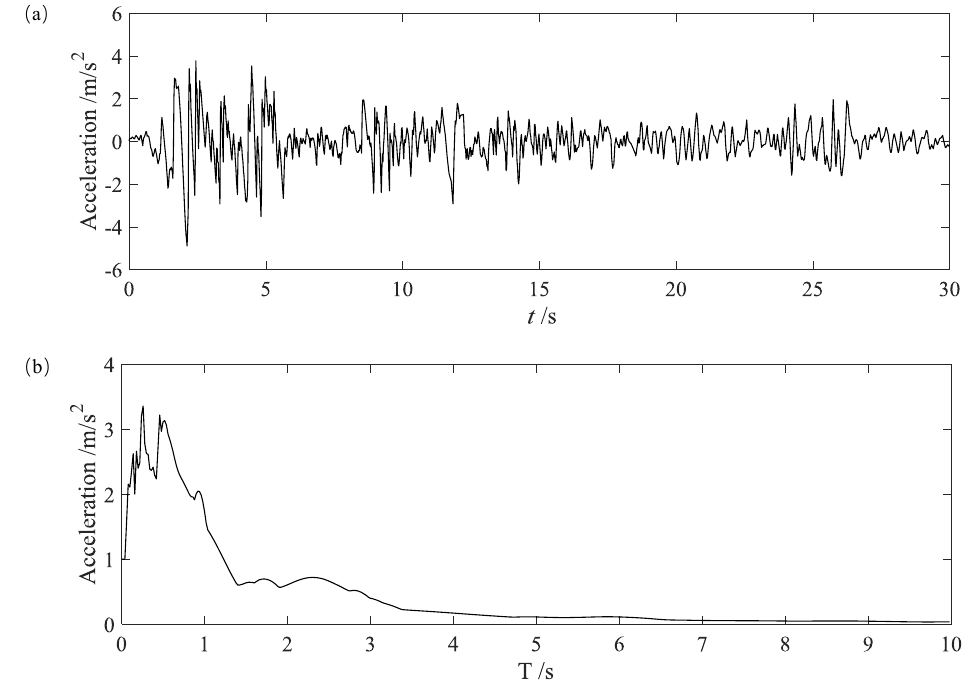
Figure 12. Spectral characteristics of the El Centro wave. ( a ) Time history. ( b ) Response spectrum. Numerical results for the initial conditions of u ( 0 ) = 0 m and ˙ u ( t ) = 0 m/s are displayed in Figure 13, where the numerical solution obtained from the Newmark al- gorithm with [ α , β ] = [1/2, 1/4] and ∆ t = 0.005 s is considered as a reference solution for comparison. TL- ϕ algorithms with the time step of 0.02 s are applied to perform the step-by-step integration. Based on the proposed selection criterion in Equations (20)–(22), ω c = min ( ˜ ω c 1 , ˜ ω c 2 ) = 8.14 rad/s and ϕ = 0.9978. Displacement errors of the 4th story derived from TL- ϕ algorithms with different values of ω c are shown in Table 14. It can be seen that both NEE and NRMSE are minimal for “TL- ϕ ( ω c = 8.14 rad/s)”, indicating that the proposed selection criterion of ω c is applicable for an MDOF that is subjected to a seismic